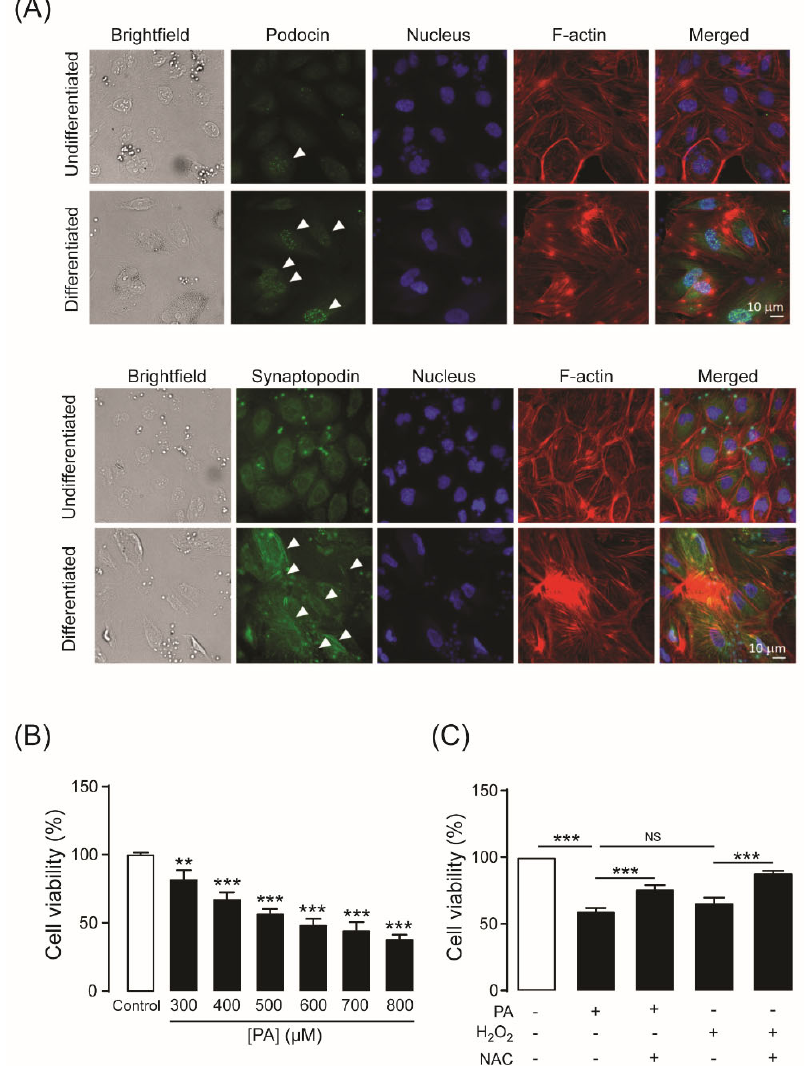
Figure 1. ( A ) Expression of podocyte-specific markers. Undifferentiated podocytes (upper panels) were cultured at 33 ◦ C (permissive temperature). Differentiated podocytes (lower panels) were cultured at 37 ◦ C (non-permissive temperature) for 14 days. Representative immunofluorescence images for podocin (green dots; arrows) and synaptopodin (green line; arrows) are shown. Podocin and synaptopodin were stained with an anti-podocin antibody and an anti-synaptopodin antibody, respectively. The nucleus was stained with Hoechst 33342 (blue color). F-actin filaments were stained with Alexa Fluor TM 568 phalloidin (with the appearance of red lines). ( B ) Concentration- dependent response of palmitic acid (PA)–induced podocyte death. Podocytes were cultured in RPMI 1640 medium containing PA at concentrations between 300 and 800 µ M for 24 h. Podocytes were incubated with 600 µ M PA or hydrogen peroxide (H 2 O 2 ) for 24 h. N -acetylcysteine (NAC) (10 mM), a glutathione precursor, was added with PA or H 2 O 2 . ( C ) Effect of PA on podocyte viability and mechanism of PA-induced podocyte death. Cell viability was measured with the MTT assay. The data are expressed as the mean ± standard error of the mean ( n = 3–6). NS, non-significant; ** p < 0.01; *** p < 0.001, compared with the control or indicated group.